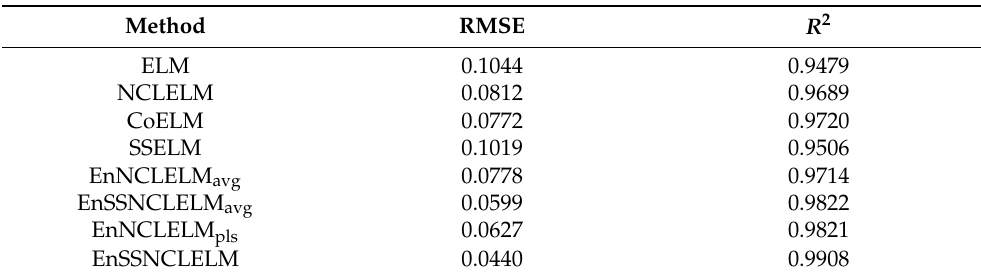
Table 2. Prediction results of penicillin concentration using different soft sensor methods in the penicillin fermentation